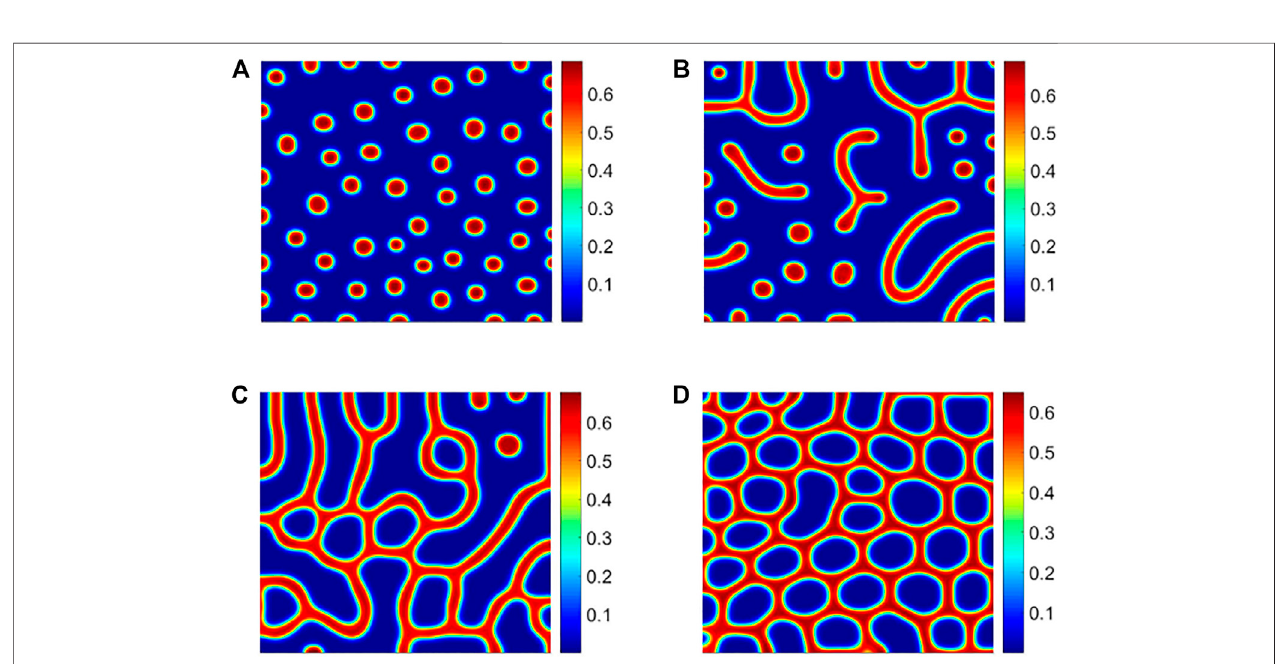
FIGURE 3 | Vegetation pattern structure under different shading rates ρ . (A) Hot spot pattern with ρ = 0.6; (B) spots – stripes mixed patternwith ρ = 0.75; (C) stripe pattern with ρ = 0.9; (D) cold spot pattern with ρ = 0.94. See Table 1 for the other parameter values.